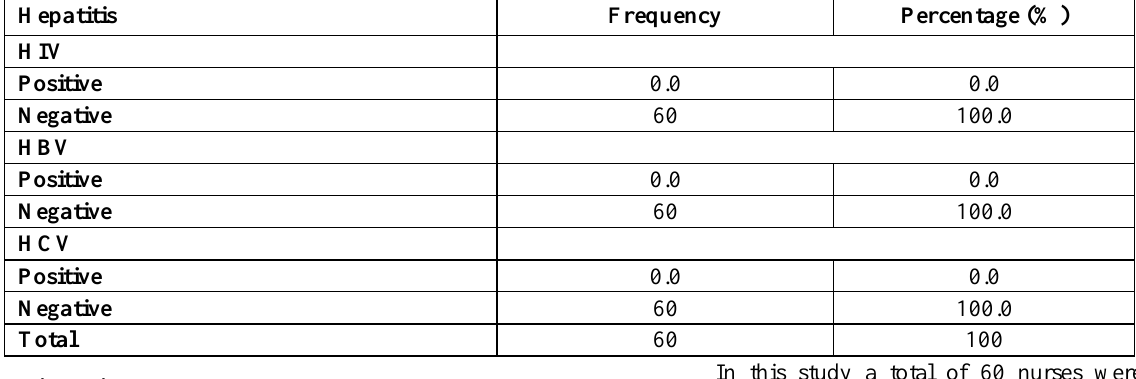
Table 4. Frequency and percentage of HIV, HCV and HBV in study